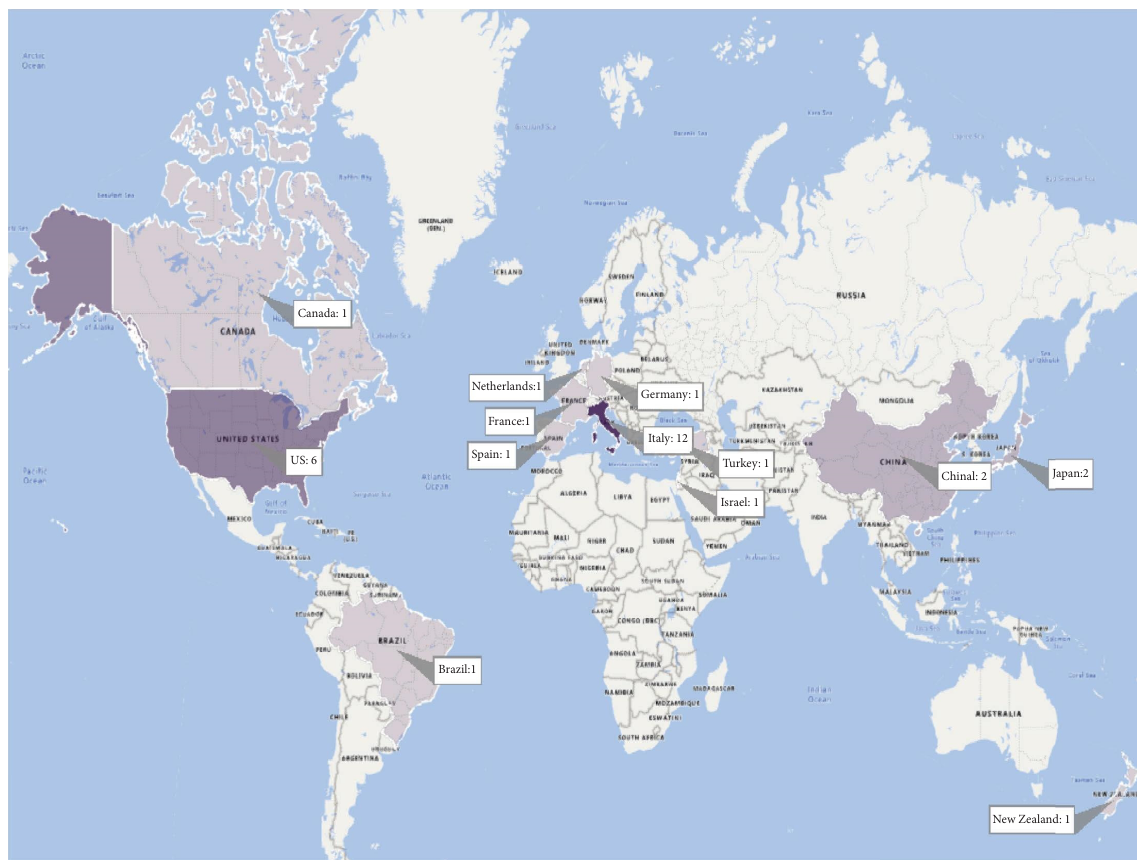
Figure 5: Te distribution of papers based on